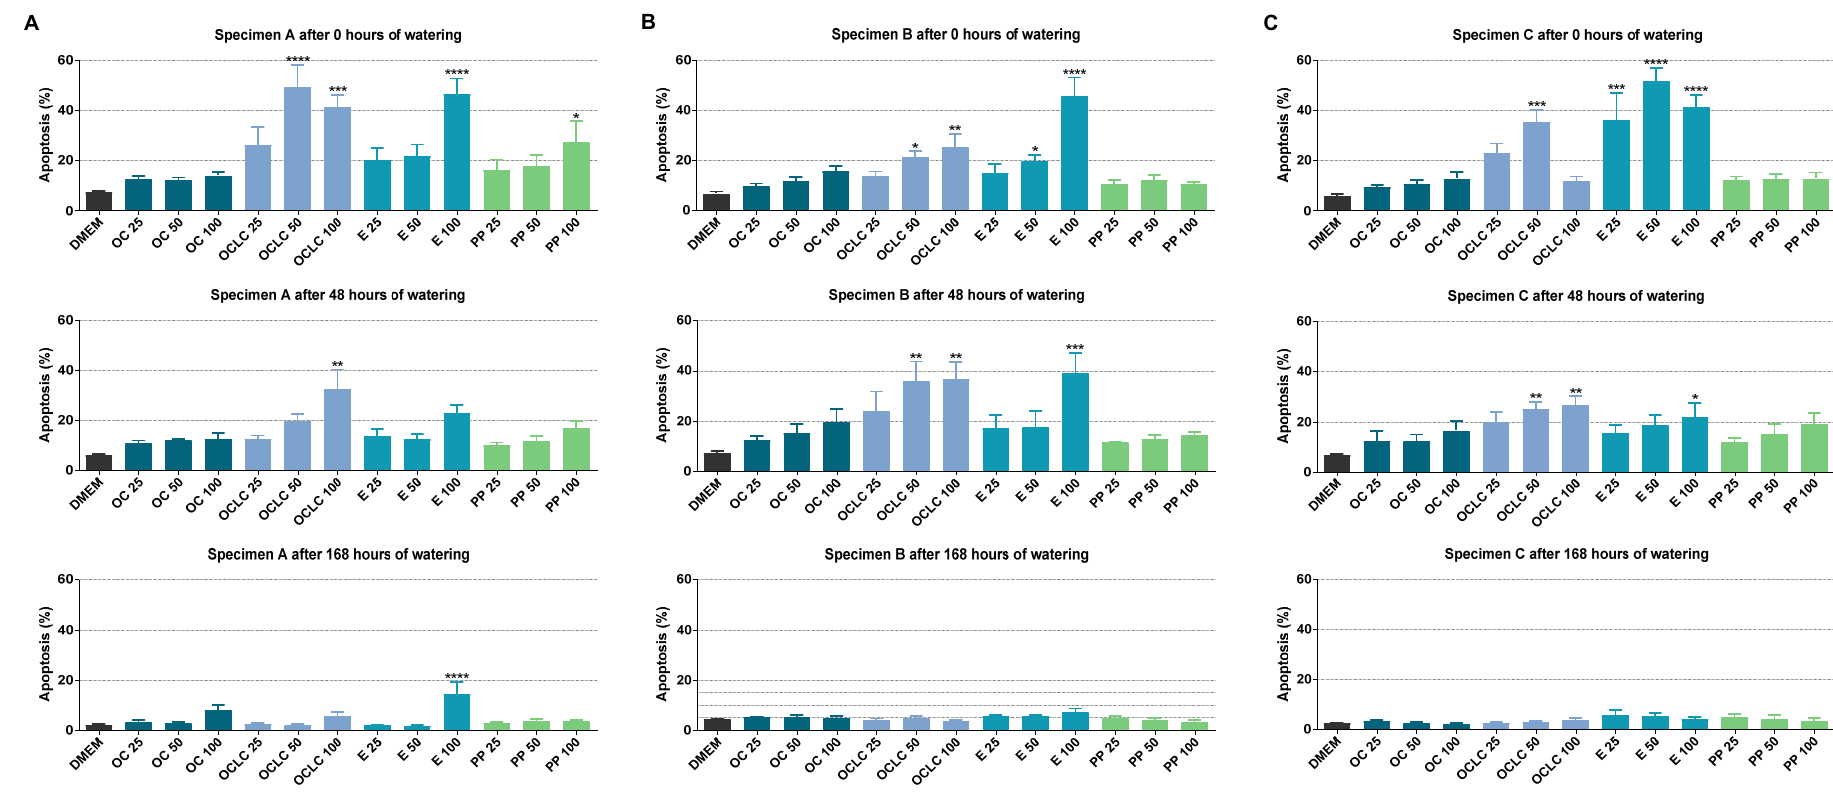
Figure 4. Early apoptosis of A549 cells measured by Annexin V-FITC-PI assay after incubation with eluates from ( A ) test specimens A (15 mm × 0.5 mm), ( B ) test specimens B (50 mm × 1.0 mm) or ( C ) test specimens C (50 mm × 3.0 mm) of different compositions (OC, Orthocryl ® ; OCLC, Orthocryl ® LC; E, Loctite ® EA 9483; PP, polypropylene) and previous watering conditions. The test specimens were stored in distilled water at room temperature for 0, 48 or 168 h followed by a 24 h storage in cell culture medium (DMEM, Dulbecco’s Modified Eagle Medium) under shaking conditions. The DMEM eluates were used undiluted (100%) or diluted (50 and 25%) for a 24 h incubation of A549 cells followed by determination of cell viability using the Annexin V-FITC-PI assay. Percentages refer to the sum of all cell populations measured in FACS analysis per treatment group (set to 100%). The data are mean values ± SEM of n = 4 per group. * p ≤ 0.05, ** p ≤ 0.01, *** p ≤ 0.001, **** p ≤ 0.0001 vs. DMEM control; one-way ANOVA with Dunnett’s post hoc test.